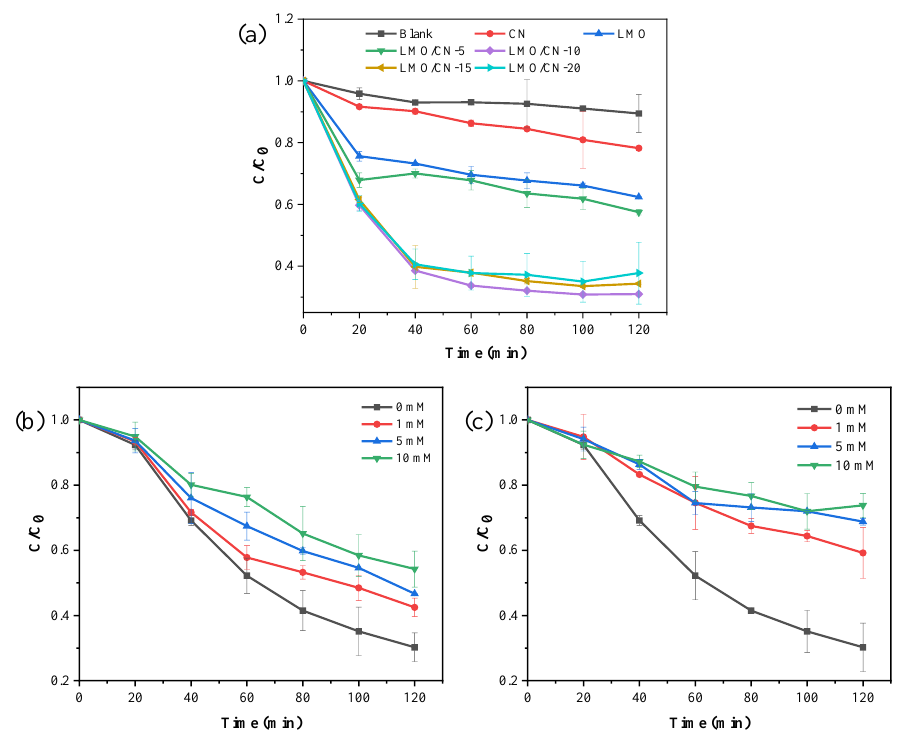
Figure 6. The TC degradation efficiency of CN, LMO, LMO/ CN-X (x = 5, 10, 15, 20) ( a ), the effect of Cl - on TC degradation efficiency ( b ), and CO 32- on TC degradation efficiency ( c ).